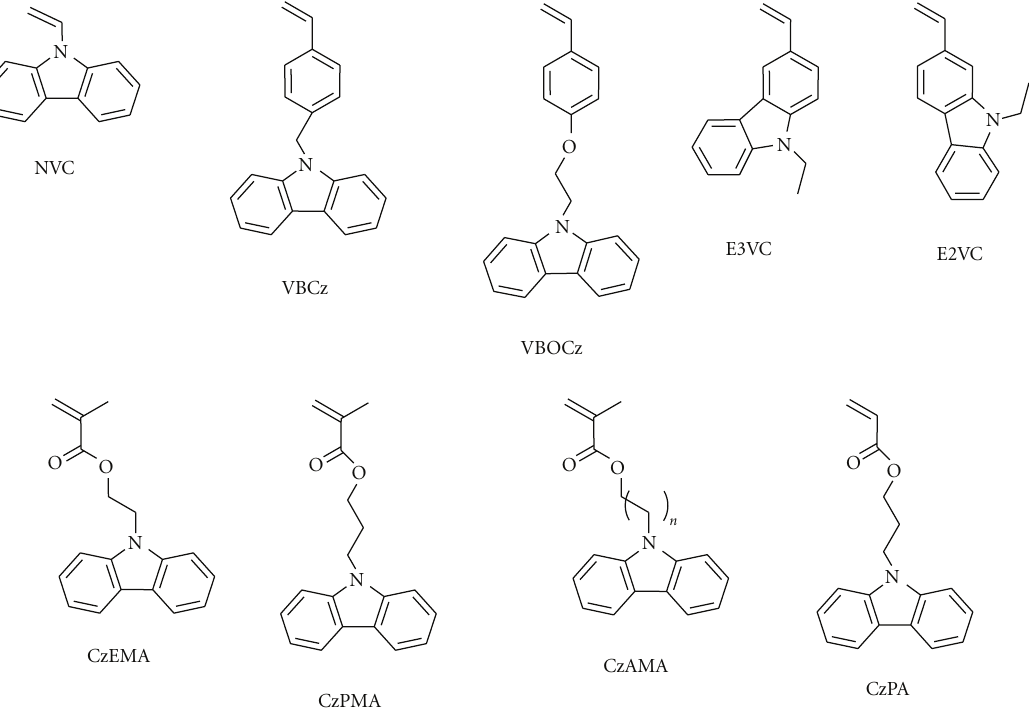
Scheme 1: Representative examples of carbazole-containing vinyl monomers used for controlled radical